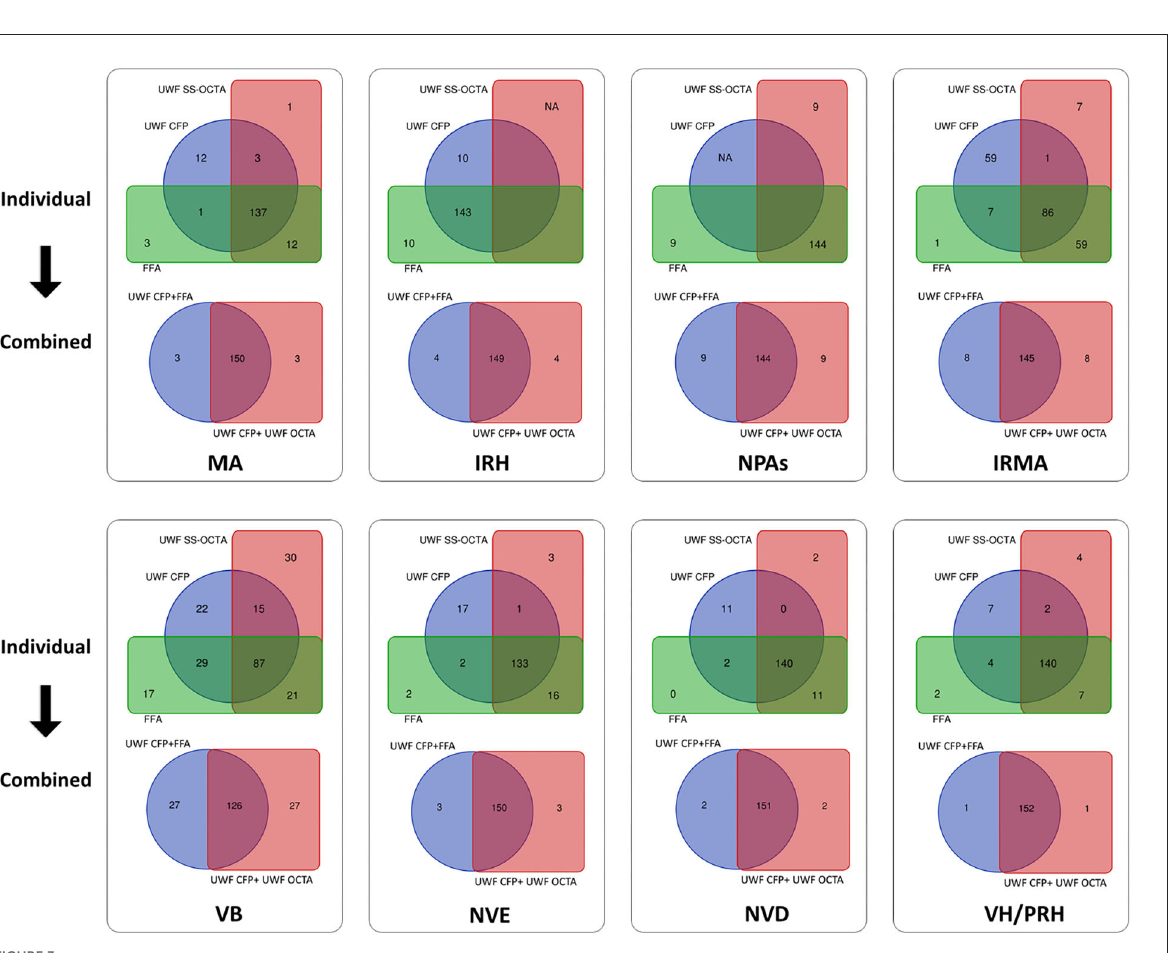
FIGURE3 Venn diagram showing the results of two combination methods for detecting DR lesions. The first and third rows show the detection number of each DR lesion by individual modalities, including UWF CFP, UWF SS-OCTA, and FFA. The second and fourth rows show the corresponding combined results of UWF CFP plus UWF SS-OCTA and UWF CFP plus FFA. During the evaluation of the presence and absence of DR lesions, the concordance rates of the three individual modalities from high to low were NP (94.1%), IRH (93.5%), NVD (91.5%), VH/PRH (91.5%), MA (89.5%), NVE (86.9%), VB (56.9%) and IRMAs (56.2%), respectively. And the concordance rates of UWF CFP plus FFA and UWF CFP plus UWF SS-OCTA from high to low were VH/PRH (99.3%), NVD (98.7%), MA (98.0%), NVE (98.0%), IRH (97.4%), IRMAs (94.8%), NPAs (94.1%), VB (82.4%),